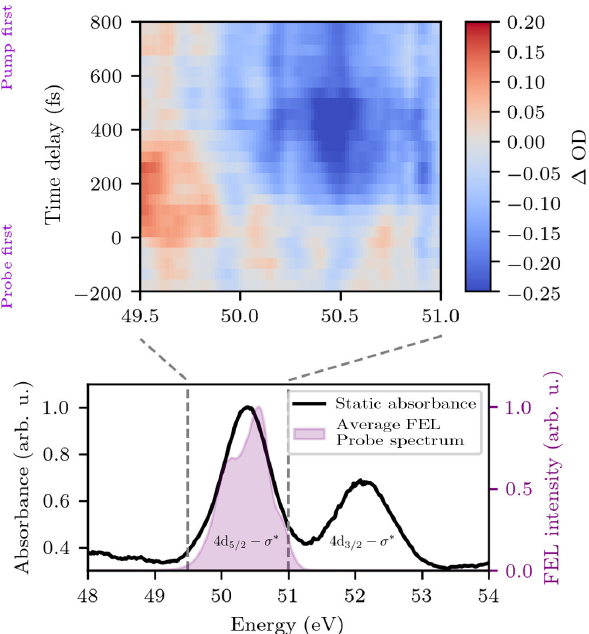
FIG. 2. Measured Δ OD around the I ∶ 4 d 5 = 2 – σ (cid:1) transition of di-iodomethane over the course of the pump-probe time delay (upper panel). In the lower panel, the static absorbance of di-iodomethane is shown, measured with a broadband XUV high-harmonic source over a wider energy range, where the spin- orbit splitting of the transition is visible. The average FEL probe spectrum with respect to the static absorbance is illustrated by violet shading.